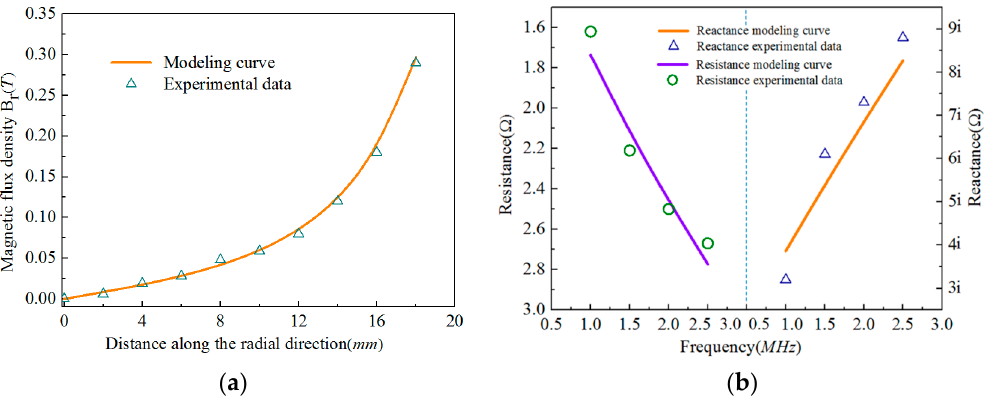
Figure 4. Comparison of the modeling magnetic flux density and the coil impedance with experimental data. ( a ) Magnetic field flux density; ( b ) Coil impedance.